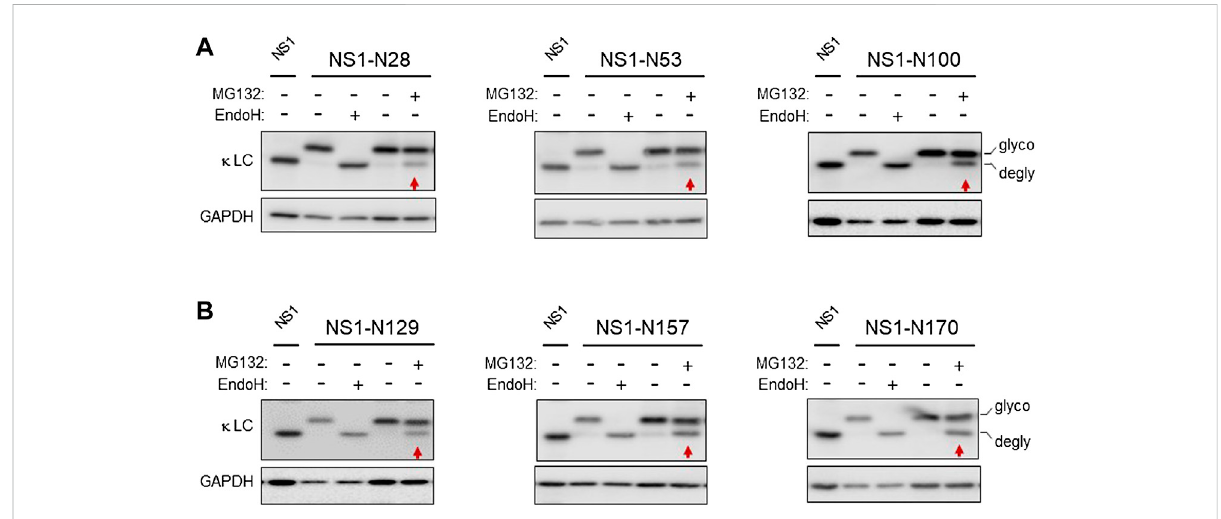
FIGURE 1 The well-folded domain in NS1 does not impede retrotranslocation. (A) Cells were transfected with the indicated NS1 constructs bearing a single N-linked glycan on the V L domain, and 24 h later cell lysates were prepared. Lysates were treated with (+) or without (-) Endo H to identify mobility of the deglycosylated and non-glycosylated forms of these constructs. In each case, the parental, non-glycosylated NS1 was used as a control for the mobility of the non-glycosylated form of NS1. One dish each of cells expressing the indicated glycosylated constructs were incubatedwith10 μ MMG132(+)orDMSOcontrol(-)for3.5 hpriortolysis.Lysateswereprepared,andonesamplewasdigestedwithEndoH(+)asa controlformobilityoftheunglycosylatedprotein,andthensampleswereanalyzedbySDS-PAGE-coupledwesternblottingwithagoatanti-mouse κ antisera.Redarrowspointatthedeglycosylated(DG)speciesineachpanel. (B) CellsweretransfectedwiththeindicatedNS1glycosylatedconstructs bearing a single glycan on the C L domain alone and processed as in (A) . Non-glycosylated NS1 was used as a control for the mobility of the non- glycosylated form of NS1. In all cases, GAPDH was used as a loading